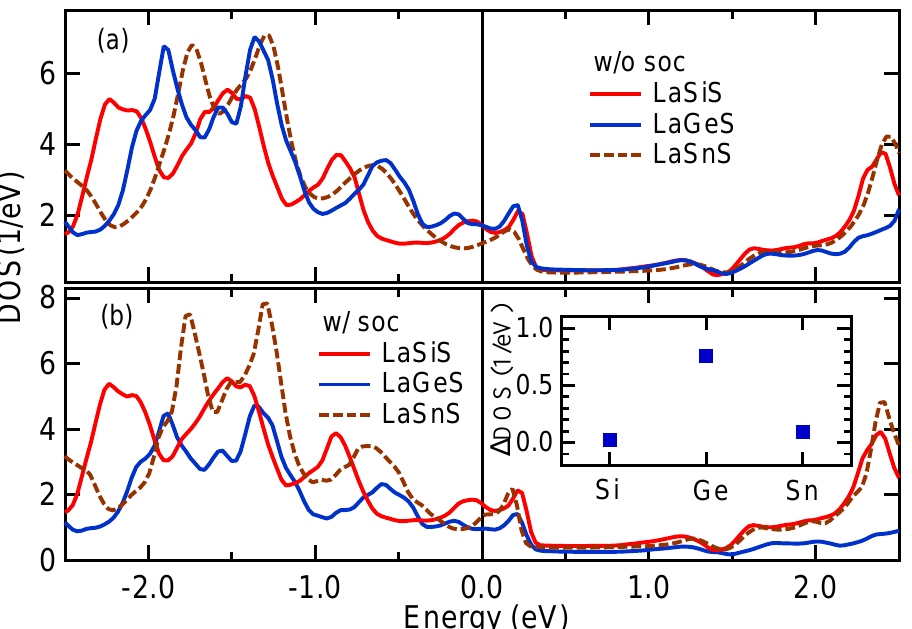
Figure 5. (Color online) Calculated total DOS for La X S compounds with and without SOC effect. Panel ( a ): Calculated DOS without SOC effect denoted by Red ( X = Si), blue ( X = Ge), and brown ( X = Sn) for three La X S compounds, respectively. Panel ( b ): Calculated DOS for La X S with SOC effect presented in Red, blue and brown for X = (Si, Ge, Sn), sequentially. The SOC strength of three samples shows in the inset. Zero energy is set to Fermi level in all